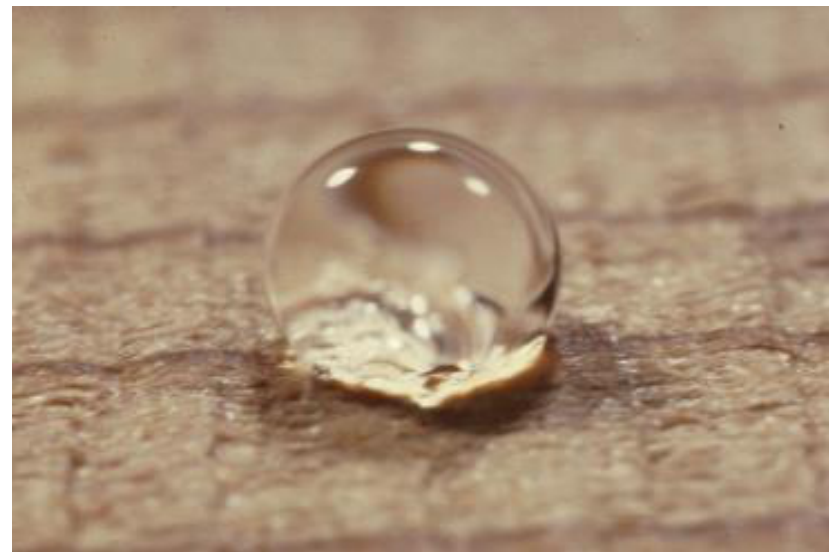
Figure 5. Water droplet on the surface of water repellent treated wood.